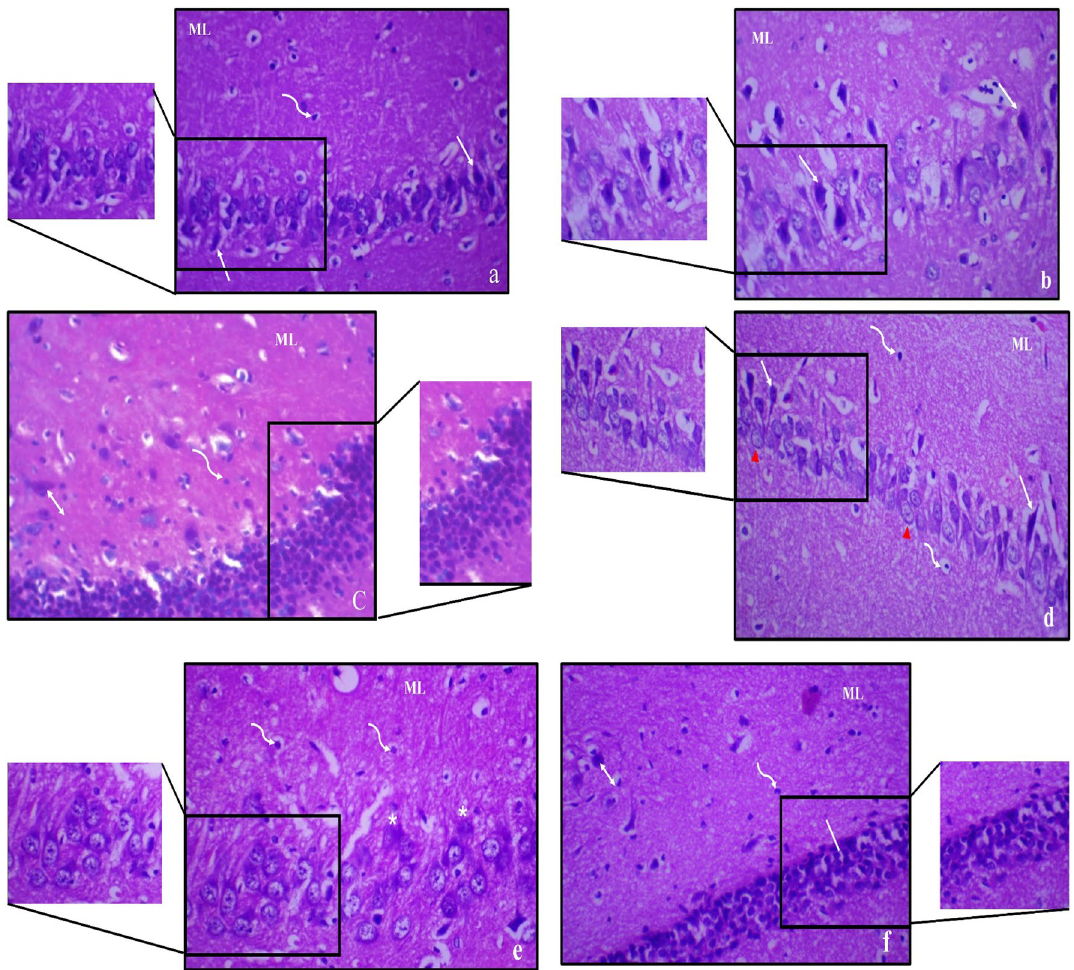
Figure 9. Photomicrograph of haematoxylin and eosin-stained sections from hippocampus of obese male rat ( a – c ) and obese female rat ( d – f ) treated with 30 mg of zinc showing dramatic improvement, where: ( a ) preservation of small pyramidal neurons with few apoptotic cells ( ↑ ); ( b ) some large pyramidal neurons with pyknotic nuclei ( ↑ ) and ( c ) preservation of granular cells with mild disorganization and vacuolation (V). Molecular layer (ML) mostly shows some enlarged neurons ( ↕ ) and many glial cells (wavy arrow); ( d ) preservation of small pyramidal cells (right pointing triangle) with few apoptotic cells ( ↑ ); ( e ) large pyramidal cells show few karyorrhectic nuclei ( * ) and ( f ) preservation of granular cells (|) and the molecular layer (ML) mostly shows few enlarged neurons ( ↕ ) and many glial cells (wavy arrow) (H & E,